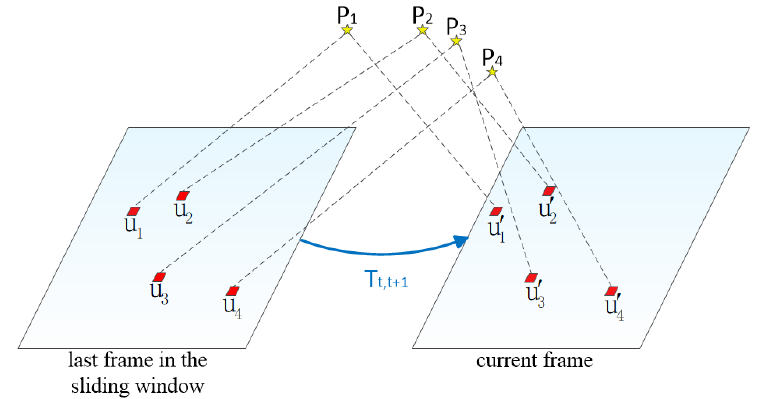
Figure 4. Adjusting the relative pose T 𝑡,𝑡+1 between the current frame and last frame in the sliding window means moving the re-projection position 𝑢 ′ of feature points on the current frame.